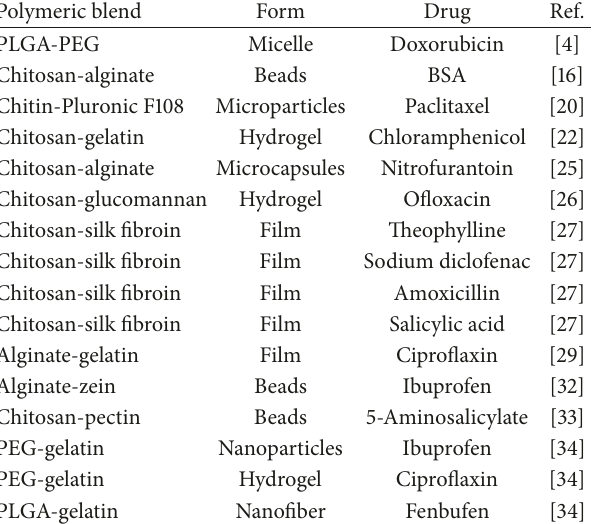
Table 1: Blended polymers as pharmaceutical forms for DDS discussed